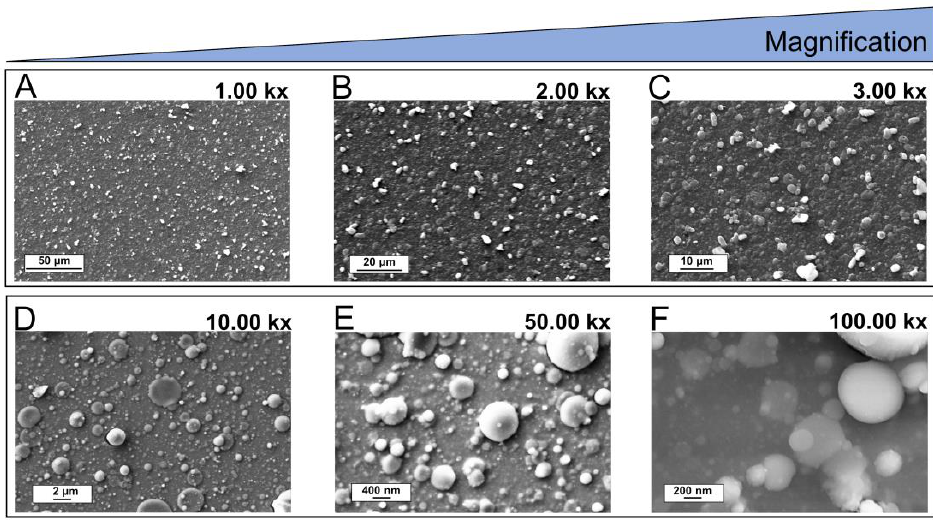
Figure 7. SEM images of Mn,Sr-TCP coating deposited on Si ( A – C ) and on Zn-Li ( D – F ) alloy. The growth of microorganisms ( S. aureus , E. coli , S. typhimurium , E. faecalis, and C. albicans ) in the presence and absence of Mn,Sr-TCP-coated Zn-Li samples are detailed in Figure 8. In Figure 8, the percentage of growth and the percentage of inhibition derived from three independent experiments are given. The growth of each organism was evalu- ated after 24 h of incubation at respective optimal growth temperatures.